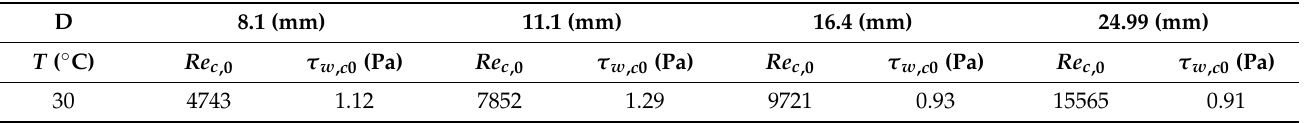
Table 4. Values of Re c ,0 and τ w , c 0 for pipes of different diameters (CAPB/DEA = 0.09%/0.075%; T = 30 ◦ C).